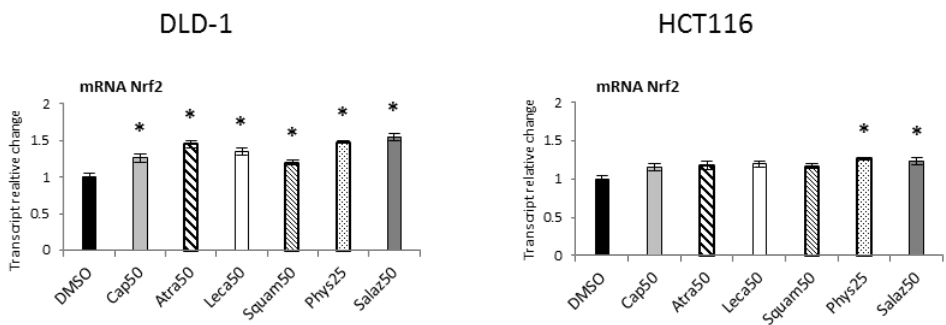
Figure 3. The effect of lichen-derived compounds on the expression of Nrf2 in DLD-1 and HCT116 cells. The values (fold of control) are presented as the means ± SEM from three separate experiments. Asterisks (*) denote statistically significant changes from the control group ( p ≤ 0.05). DMSO , vehicle control; Cap50 , caperatic acid (50 µM); Atra50 , atranorin (50 µM); Leca50 , lecanoric acid (50 µM); Squam50 , squamatic acid (50 µM); Phys25 , physodic acid (25 µM); Salaz50 , salazinic acid (50 µM).